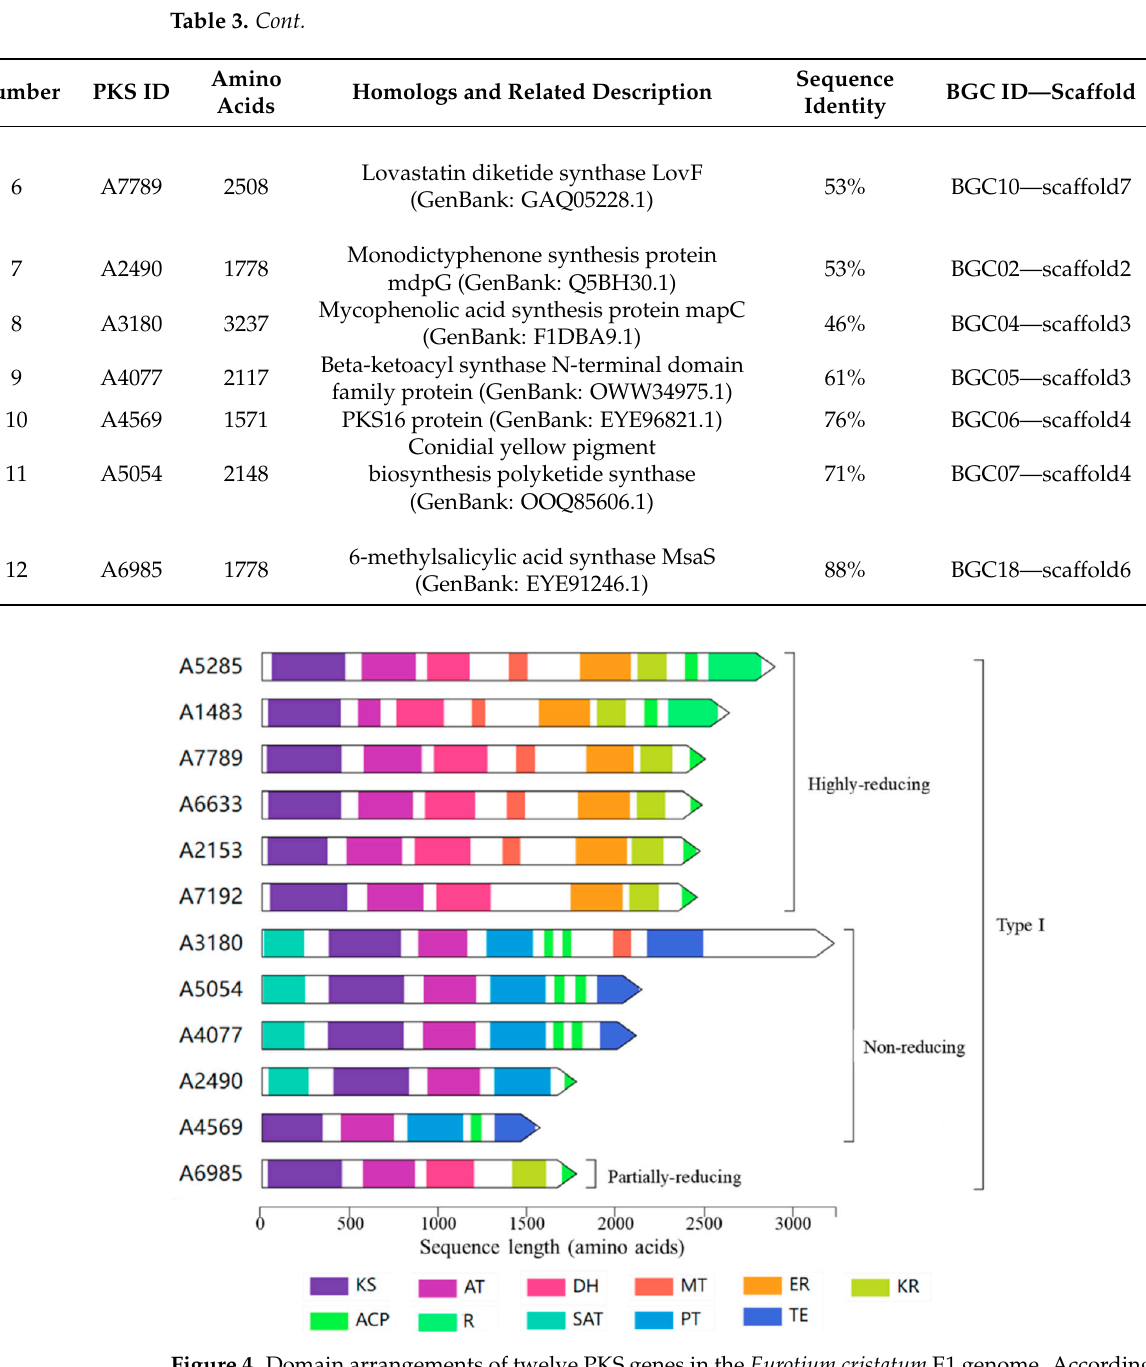
Figure 4. Domain arrangements of twelve PKS genes in the Eurotium cristatum E1 genome.